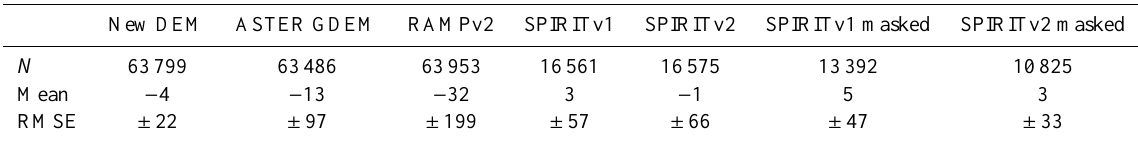
Table 2c. Mean elevation di ff erences from ICESat in regions with real-surface slope < 30°. N is the number of ICESat points. Mean and RMSE are in metres and all datasets are with respect to the EGM96 Geoid.